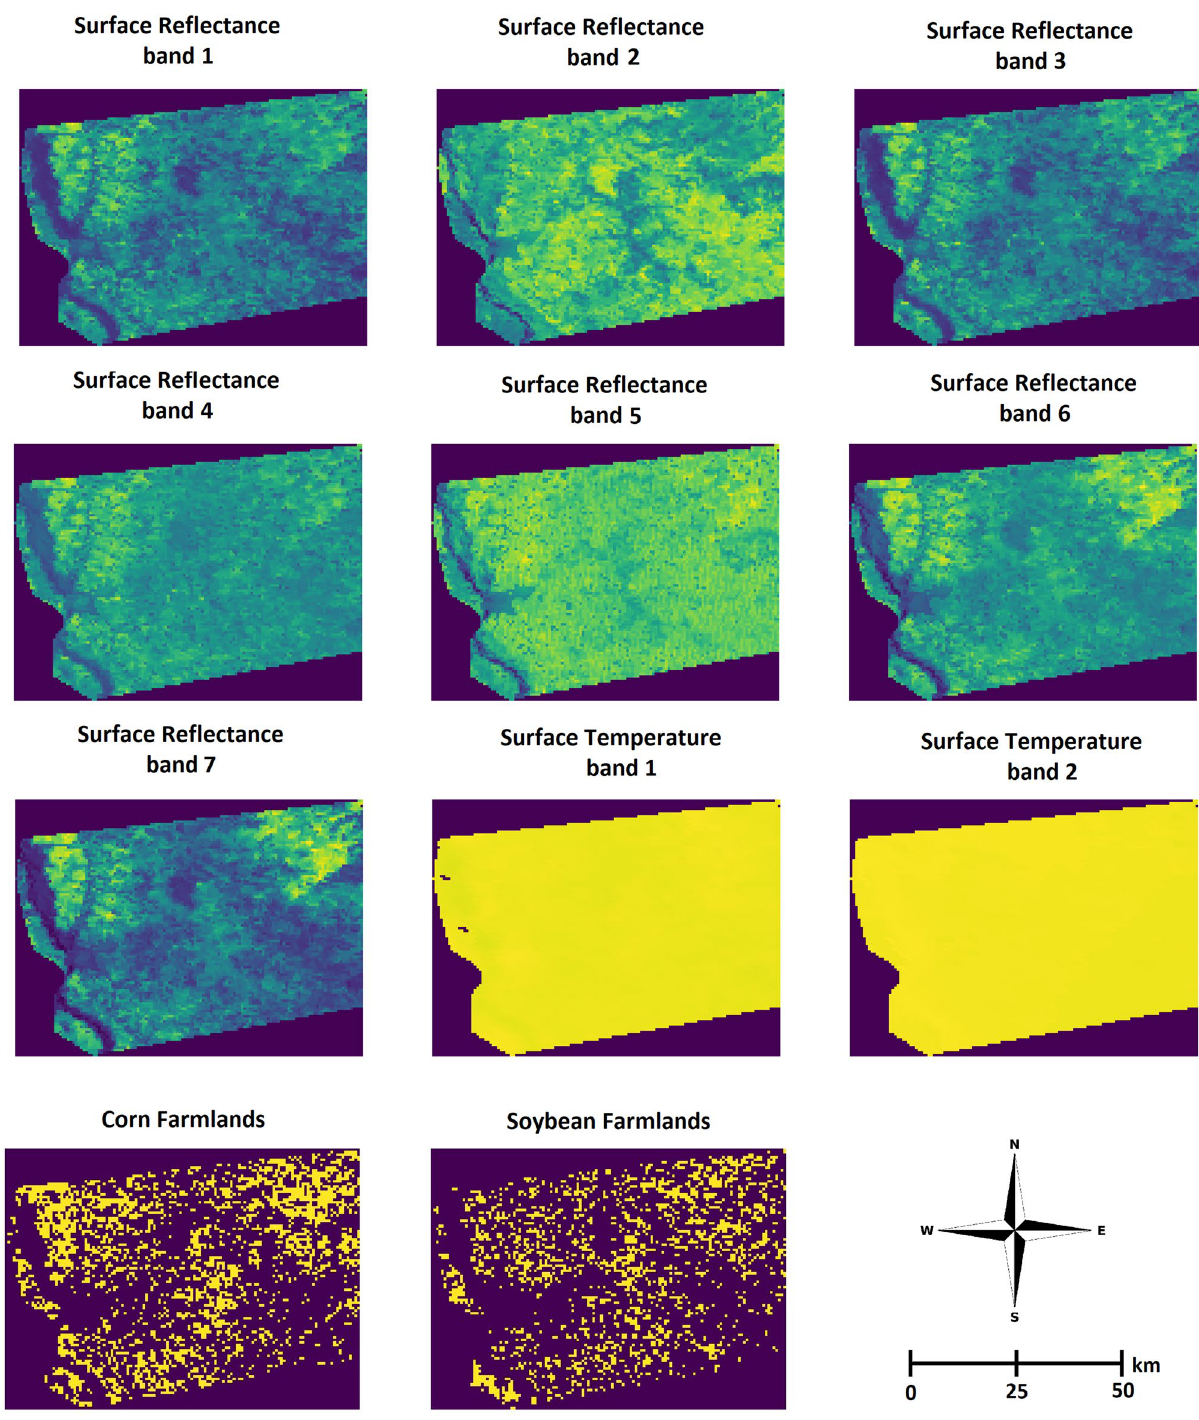
Figure 3. The multispectral images of surface spectral reflectance and land surface temperature for Adams county in Illinois captured on May 8th, 2011. Corn and soybean farmland images indicate cropland areas within the Adams county in Illinois in year